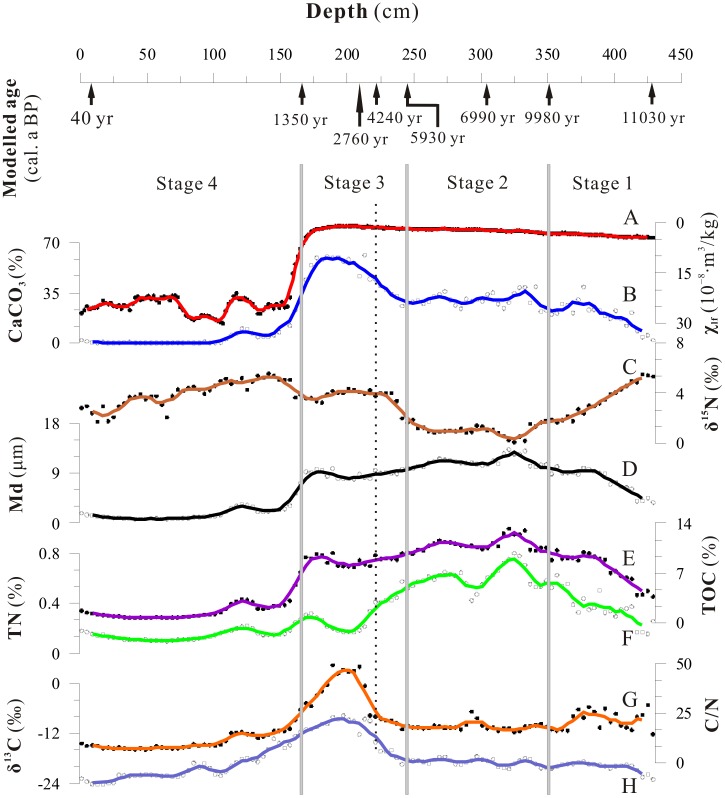
Multi-proxies results from Xingyun lake sediments: (A) magnetic susceptibility χlf and CaCO3; (B) grain size and δ15N; (C) TOC and TN; (D) C/N and δ13C. 14C AMS control points for Xingyun core are denoted on upper axis, and each curve is the 5 data running average value of the proxies.The gray bars highlight the boundary between Stage 1(429–351 cm, 11060–9980 yr BP, Younger Dryas and the early Holocene), Stage 2 (351–243 cm, 9,980–5930 yr BP, strongest summer monsoon in the Holocene), Stage 3 (243–167 cm, 5930–1350 yr BP, weaker summer monsoon) and Stage 4 (167–0 cm, 1350 yr BP to present, intensified human activities).